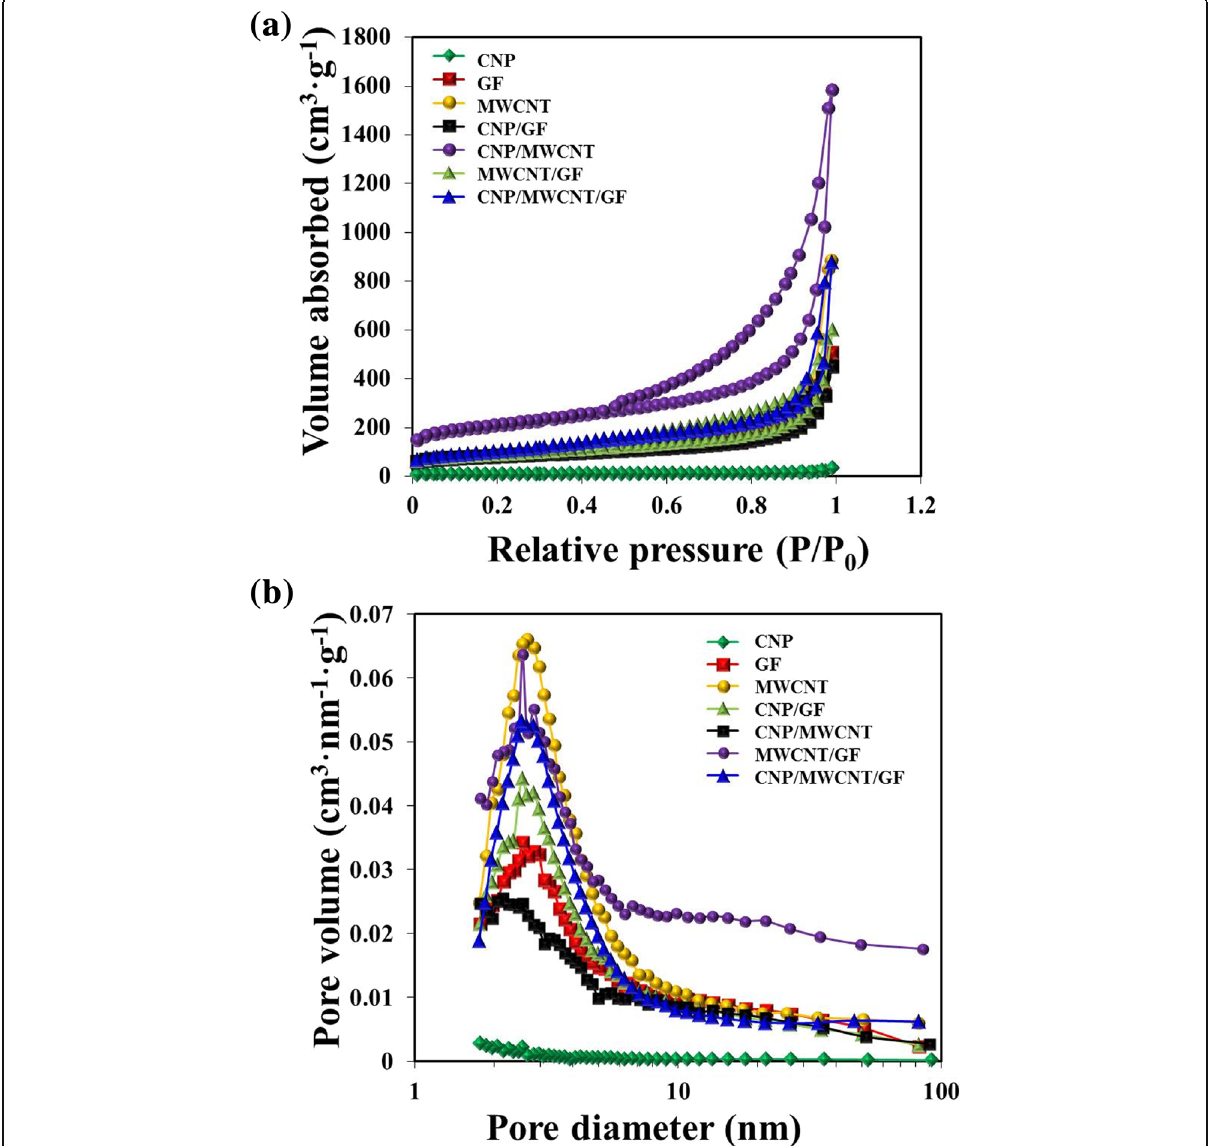
Fig. 3 a Nitrogen adsorption and desorption curves. b Pore volume distributions of CNP, MWCNT, GF, MWCNT/GF, CNP/GF, CNP/MWCNT, and CNP/MWCNT/GF